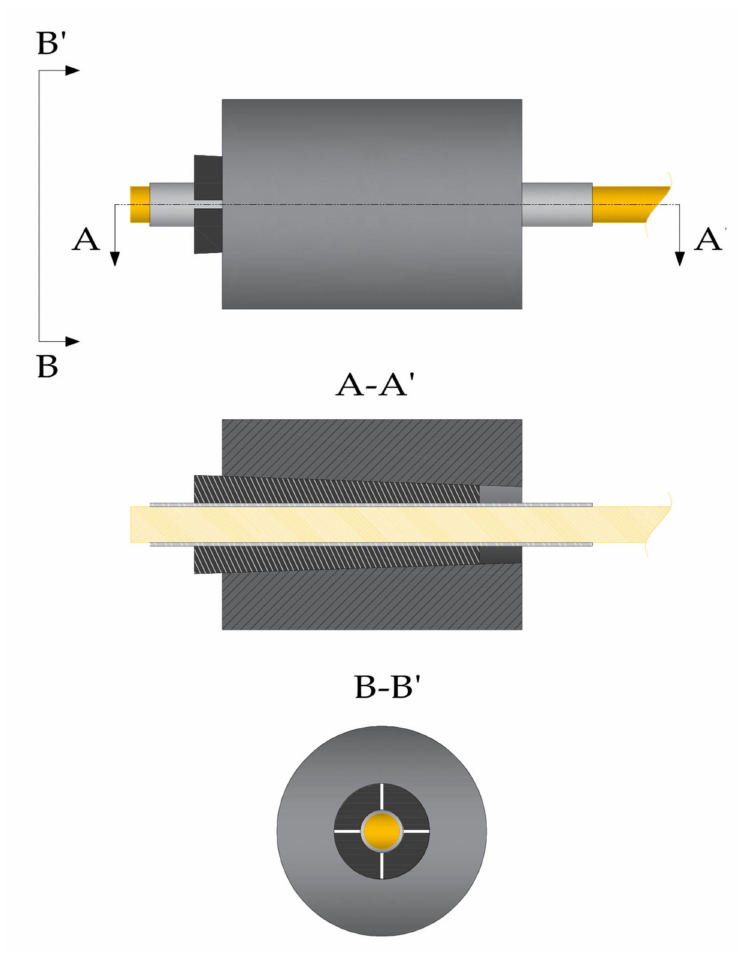
Figure 4. Example of a split wedge anchorage. The FRP cable, protected by a metallic sleeve, is arranged into a tapered barrel together with two or more